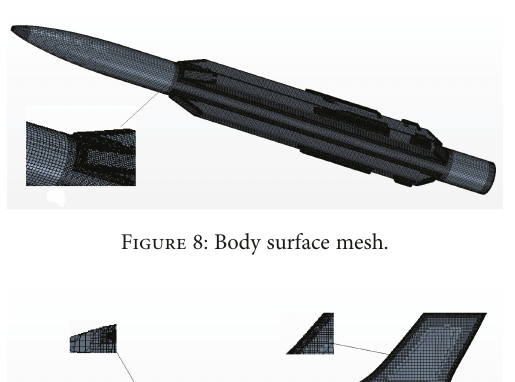
Figure 7: Side view of computational domain.